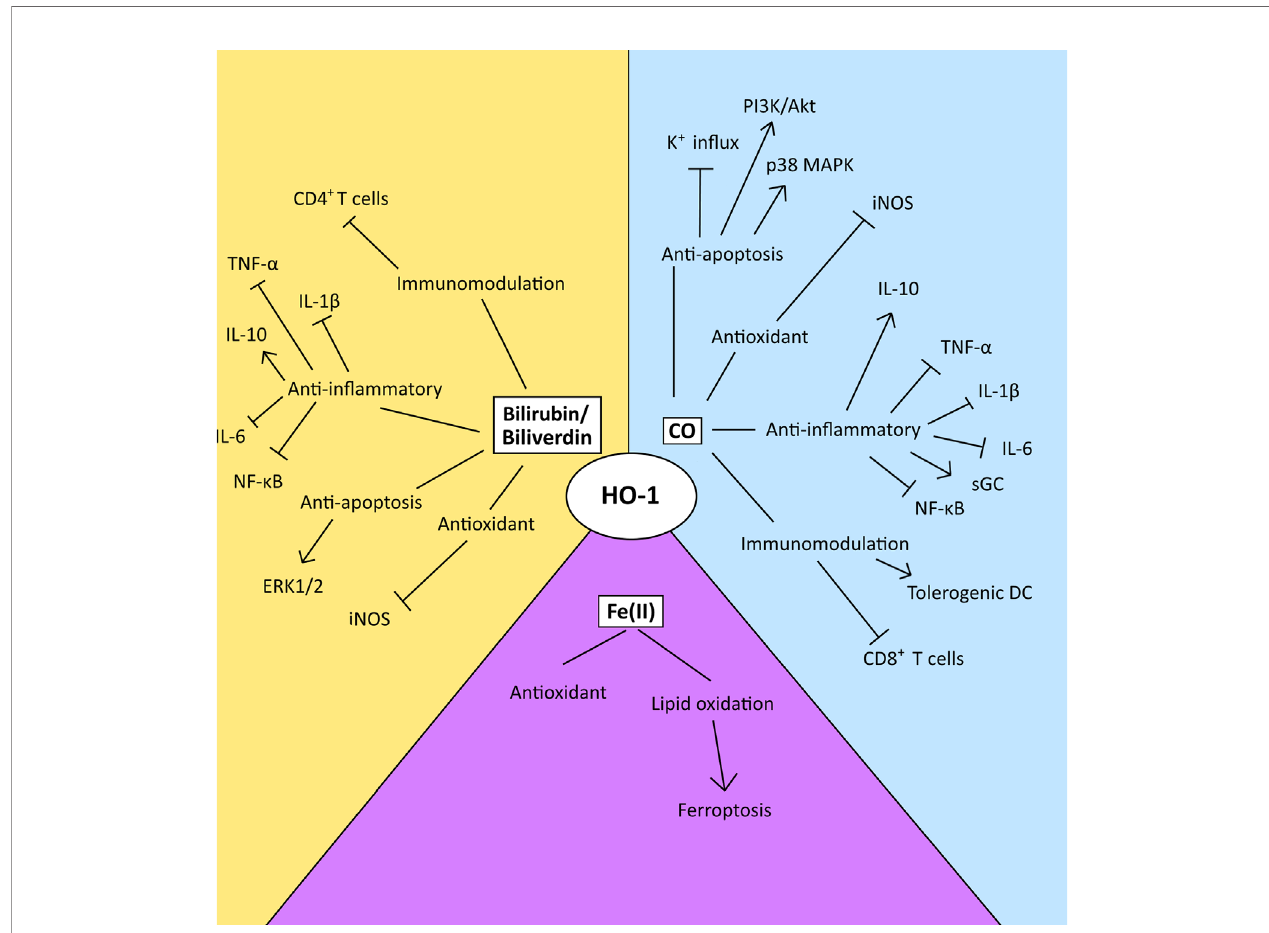
FIGURE 3 | The diverse range of possible modulatory effects of the heme catabolites generated by the enzyme activity of HO-1 in the TME. This fi gure summarizes the possible modulatory effects of the heme catabolites in the TME. However, the relative utilization and biological importance of each pathway in disease progression or control is TME-dependent and key observations relating to these pathways are discussed within the text. CO and biliverdin/bilirubin mediate their anti- apoptotic effects via the modulation of signal transduction, and the inhibition of K + in fl ux. Their antioxidant effects are mediated via the inhibition of iNOS. Both CO and biliverdin/bilirubin inhibit the activity of pro-in fl ammatory cytokines, the NF- k B pathway and increase production of IL-10, and CO also activates sGC. CO induces the maturation of tolerogenic DCs and inhibits the activity and proliferation of CD8 + T-cells, while bilirubin inhibits the activation of CD4 + T-cells. Ferrous iron [Fe (II)] enacts antioxidant effects via ferritin, however, an imbalance between ROS levels and iron overload can lead to lipid oxidation and